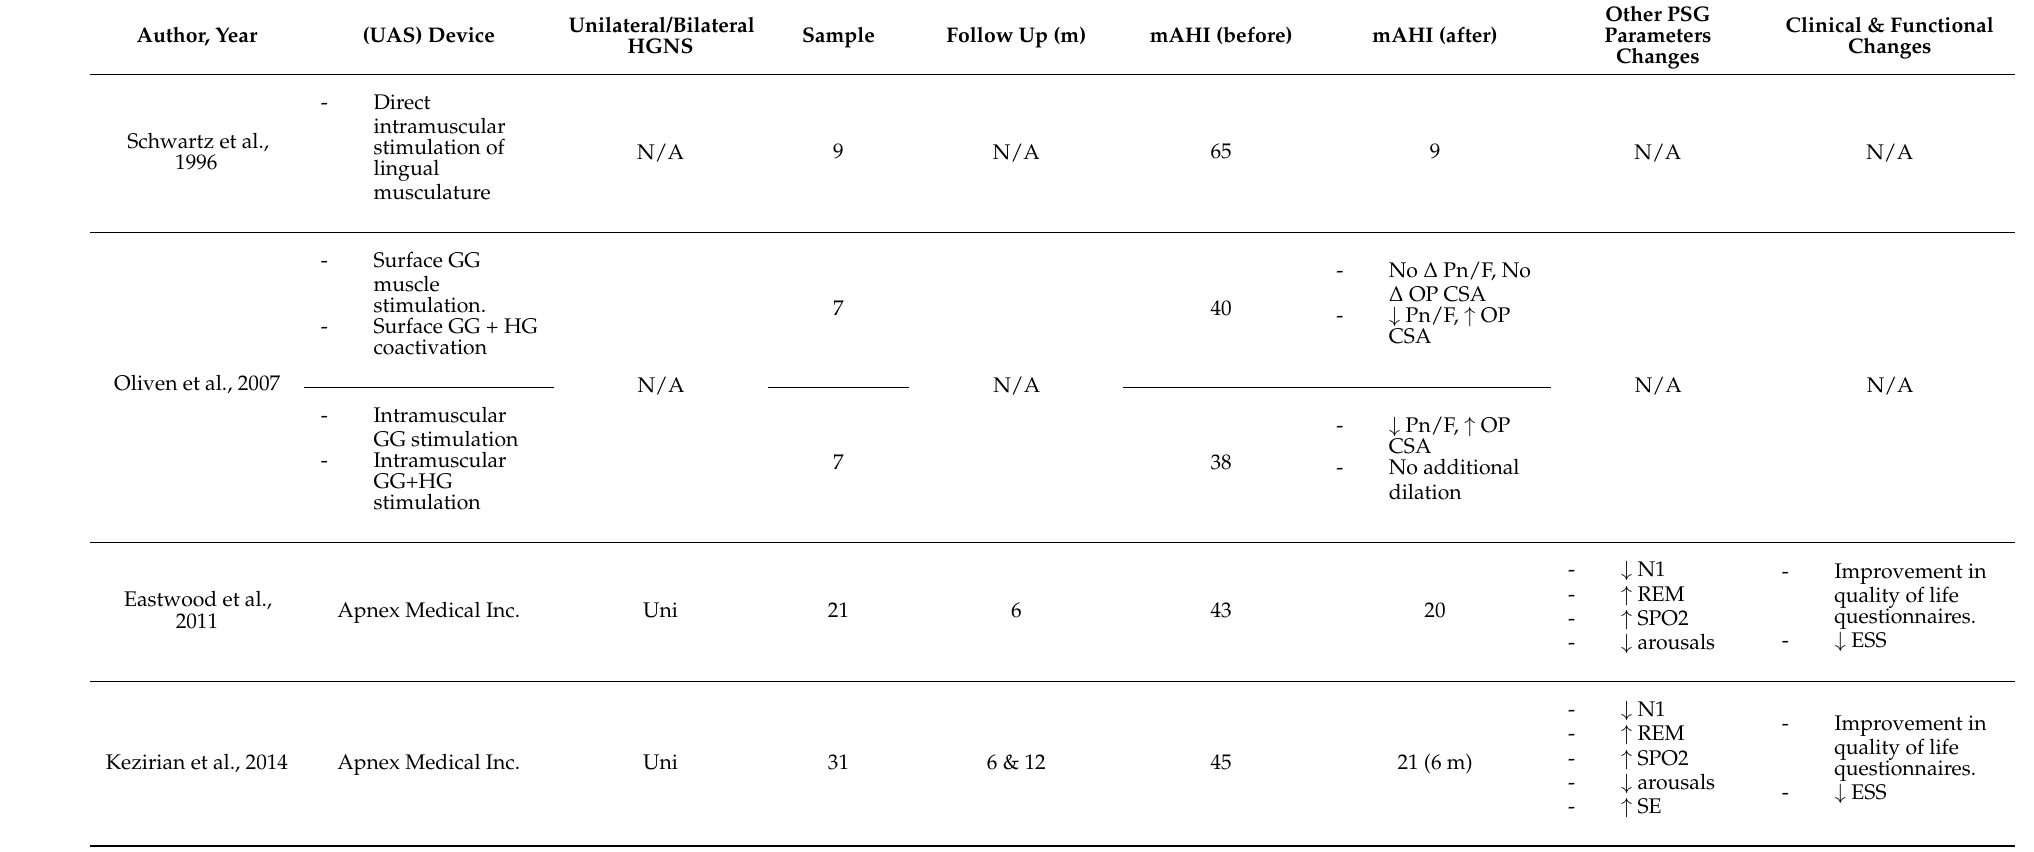
Table 1. Clinical trials conducted using hypoglossal nerve stimulation in